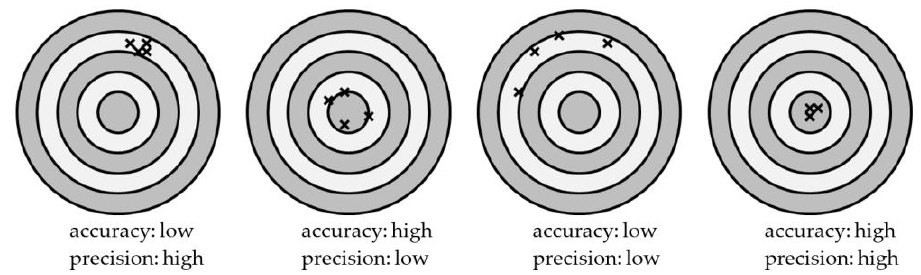
Figure 3. Visualization of accuracy and precision.